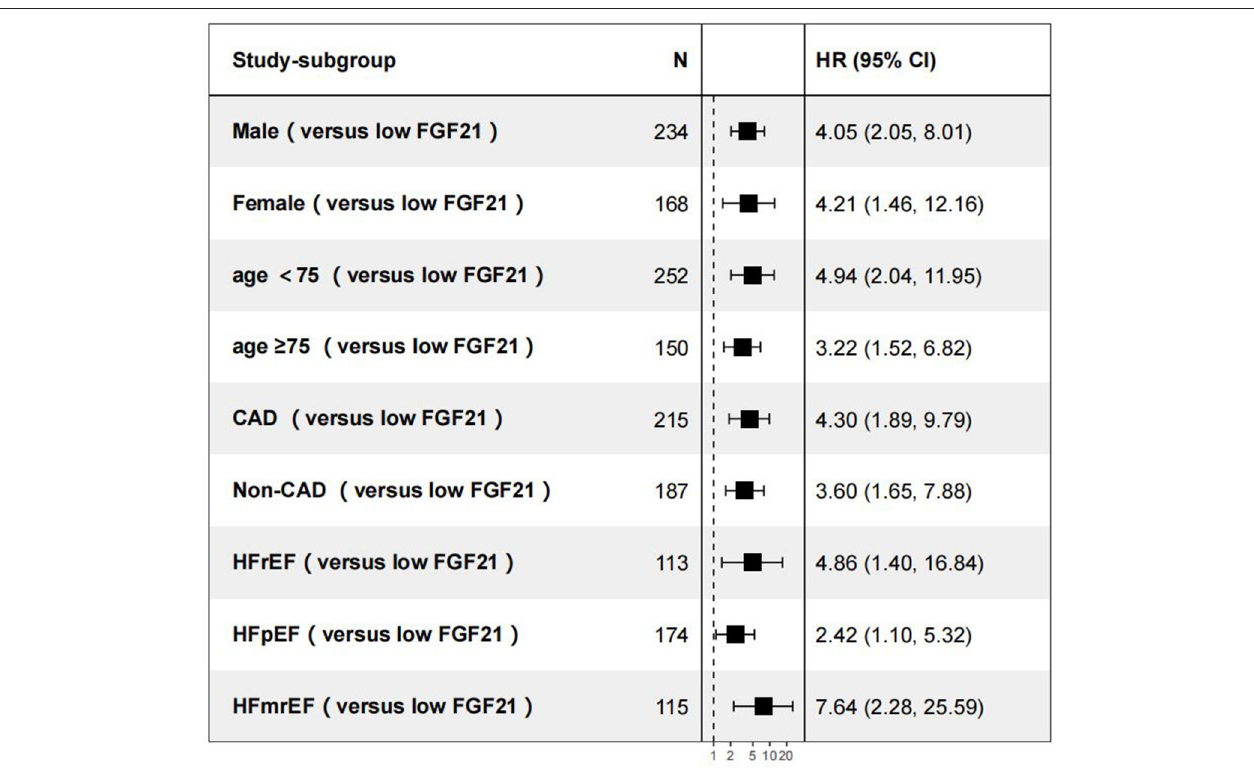
FIGURE 5 | Subgroup analyses of all-cause death vs. the low FGF21 group. CAD, coronary artery disease; HFpEF, heart failure with preserved ejection fraction; HFrEF, heart failure with reduced ejection